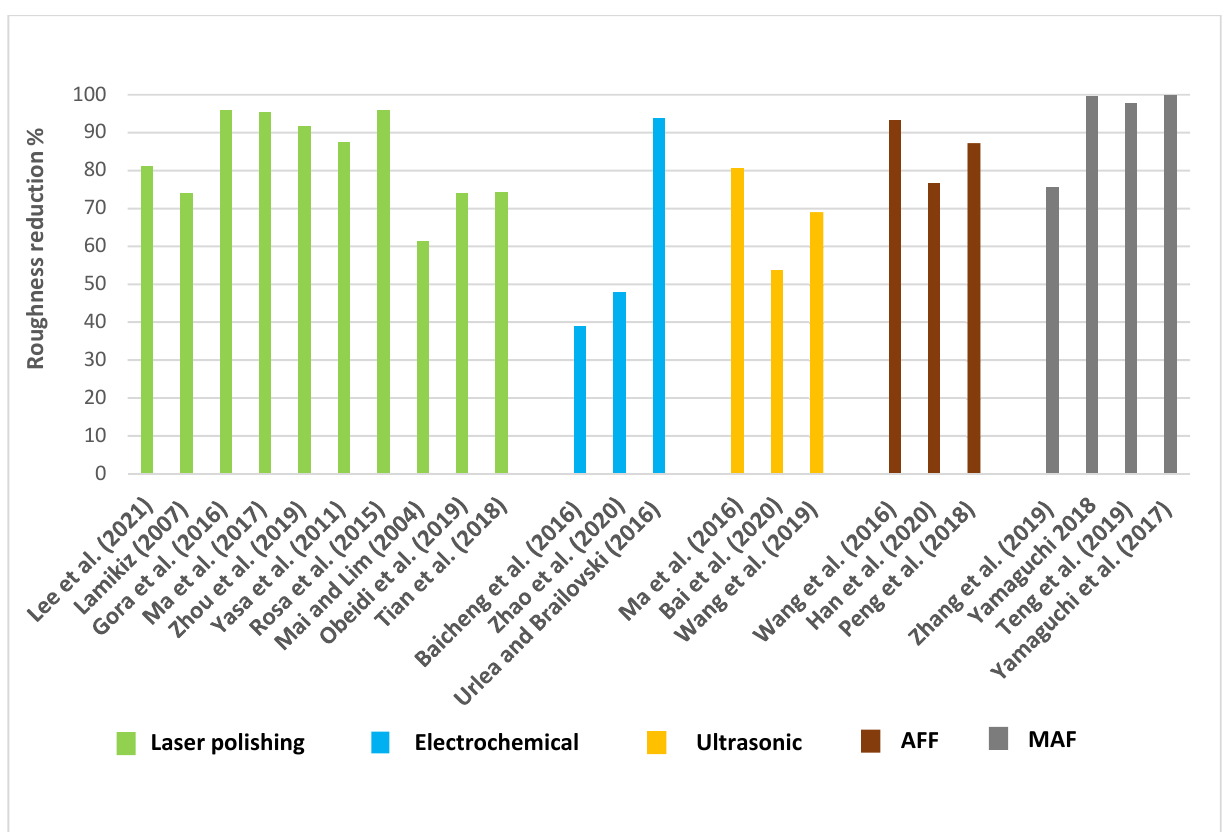
Figure 21. Resultant roughness reduction summary [38,39,41–44,46,50,51,53,67,69,75,102,104,105,110,112,113,115–118].